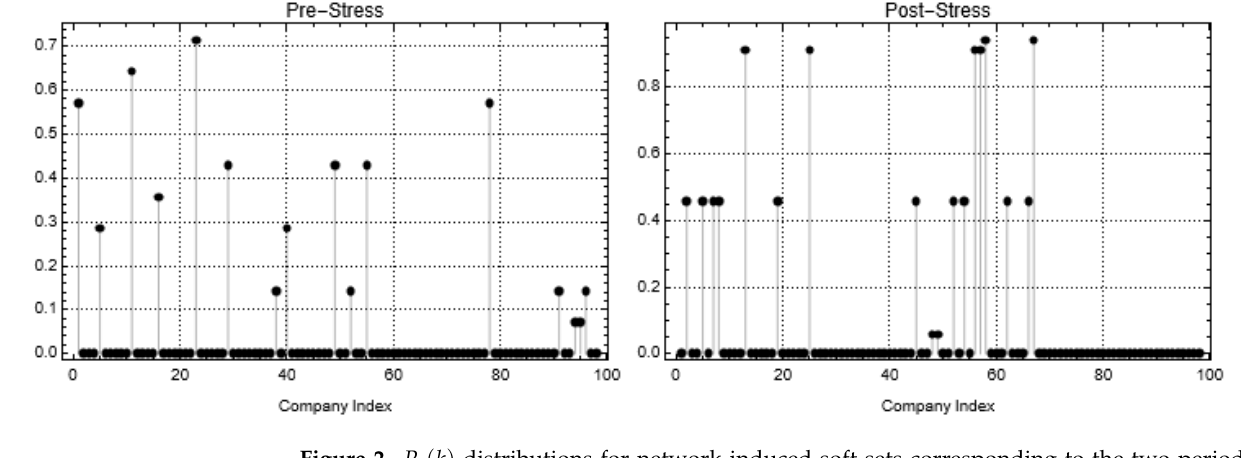
Figure 2. P v ( k ) distributions for network-induced soft sets corresponding to the two periods of economic stress in 2018. Note: The distribution on the left corresponds to the pre-stress period, while the distribution on the right corresponds to the post-stress period.